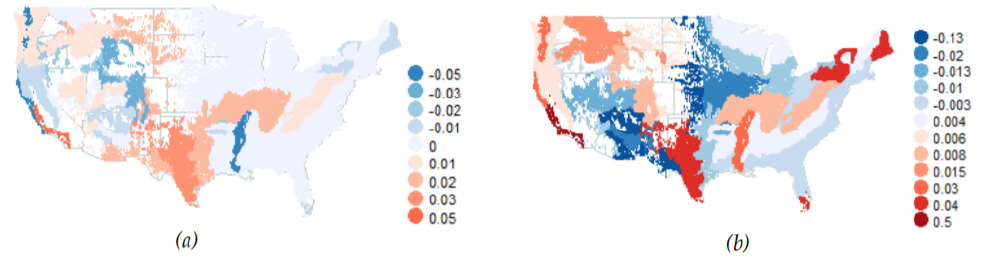
Figure 4. ( a ) Empirical average basal area growth rate (over all years when an ecoregion was observed) diagram, and ( b ) empirical means of increments of basal area yearly averages